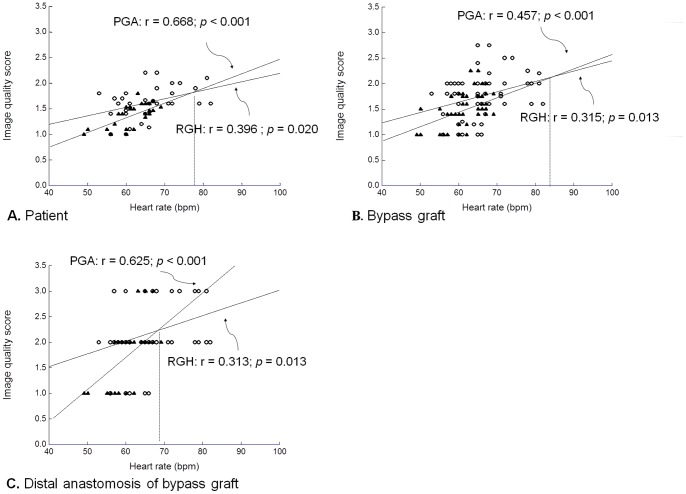
Scatter plot of heart rate (HR) in RGH group and PGA group as against the image quality scores for (A) patient-based, (B) bypass graft-based and (C) distal anastomosis of bypass graft-based analysis (Results of other segments were similar and were not shown here).Hollow circles indicate data for RGH, solid triangles indicate data for PGA, and lines represent linear regression model.